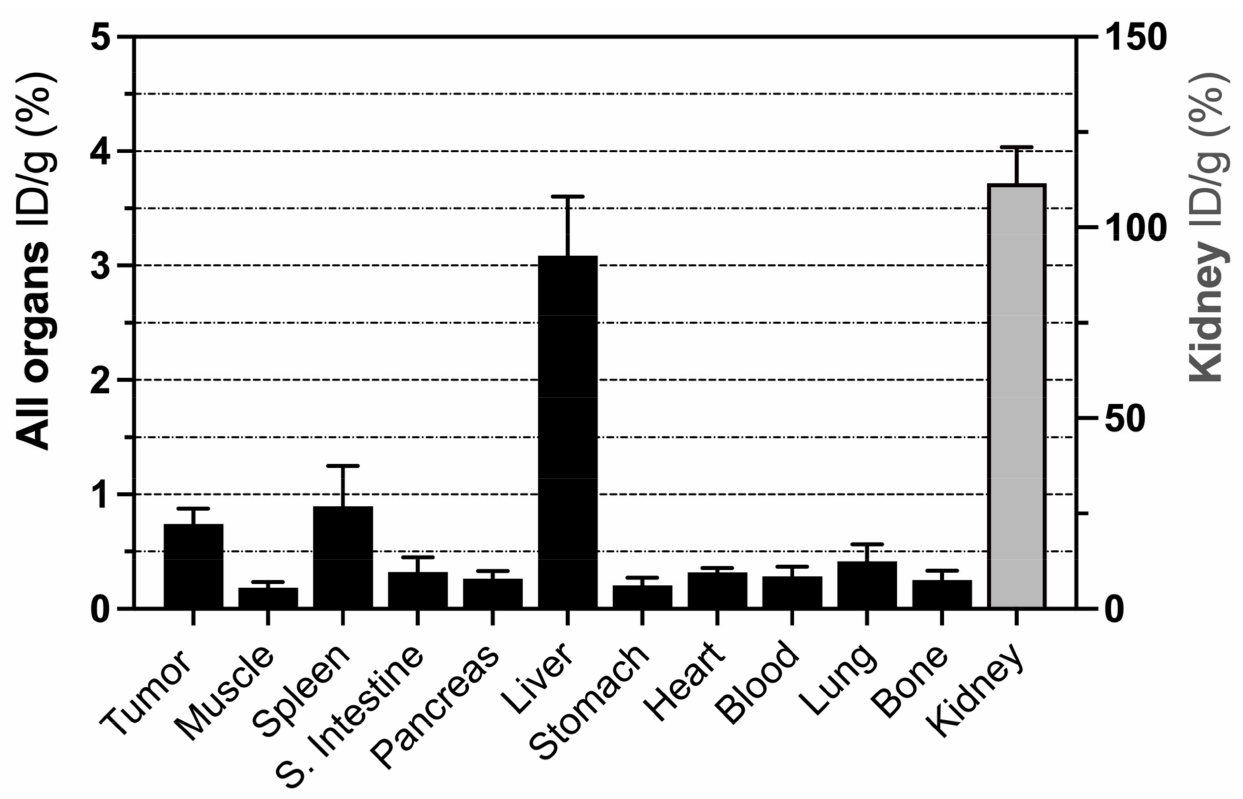
Figure 3. Biodistribution profile of 68 Ga-C2Am. COLO205-tumor-bearing mice were treated with MEDI3039 (0.4 mg/kg, i.v., 24 h before 68 Ga-C2Am administration). 68 Ga-C2Am was injected (5 MBq, ~1 mg/kg, i.v.) and tissues collected post-mortem 2 h following probe administration. Fraction of injected dose per gram of tissue (ID/g, %) (mean ± SEM, N = 5). Standardized uptake values were calculated as maximum (SUVmax) and mean (SUV). SUV was defined Cimg/(ID/BW) where Cimg is the activity concentration (MBq/mL), ID is injected activity (MBq), and BW is body weight (g). SUVmax was calculated from the pixel with the maximum signal